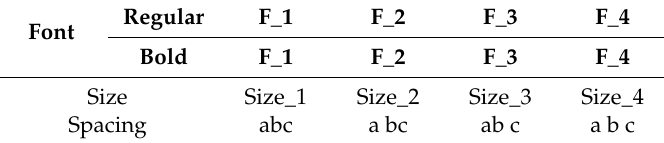
Table 3. Set of di ff erent values of three geometrics parameters of each resonator